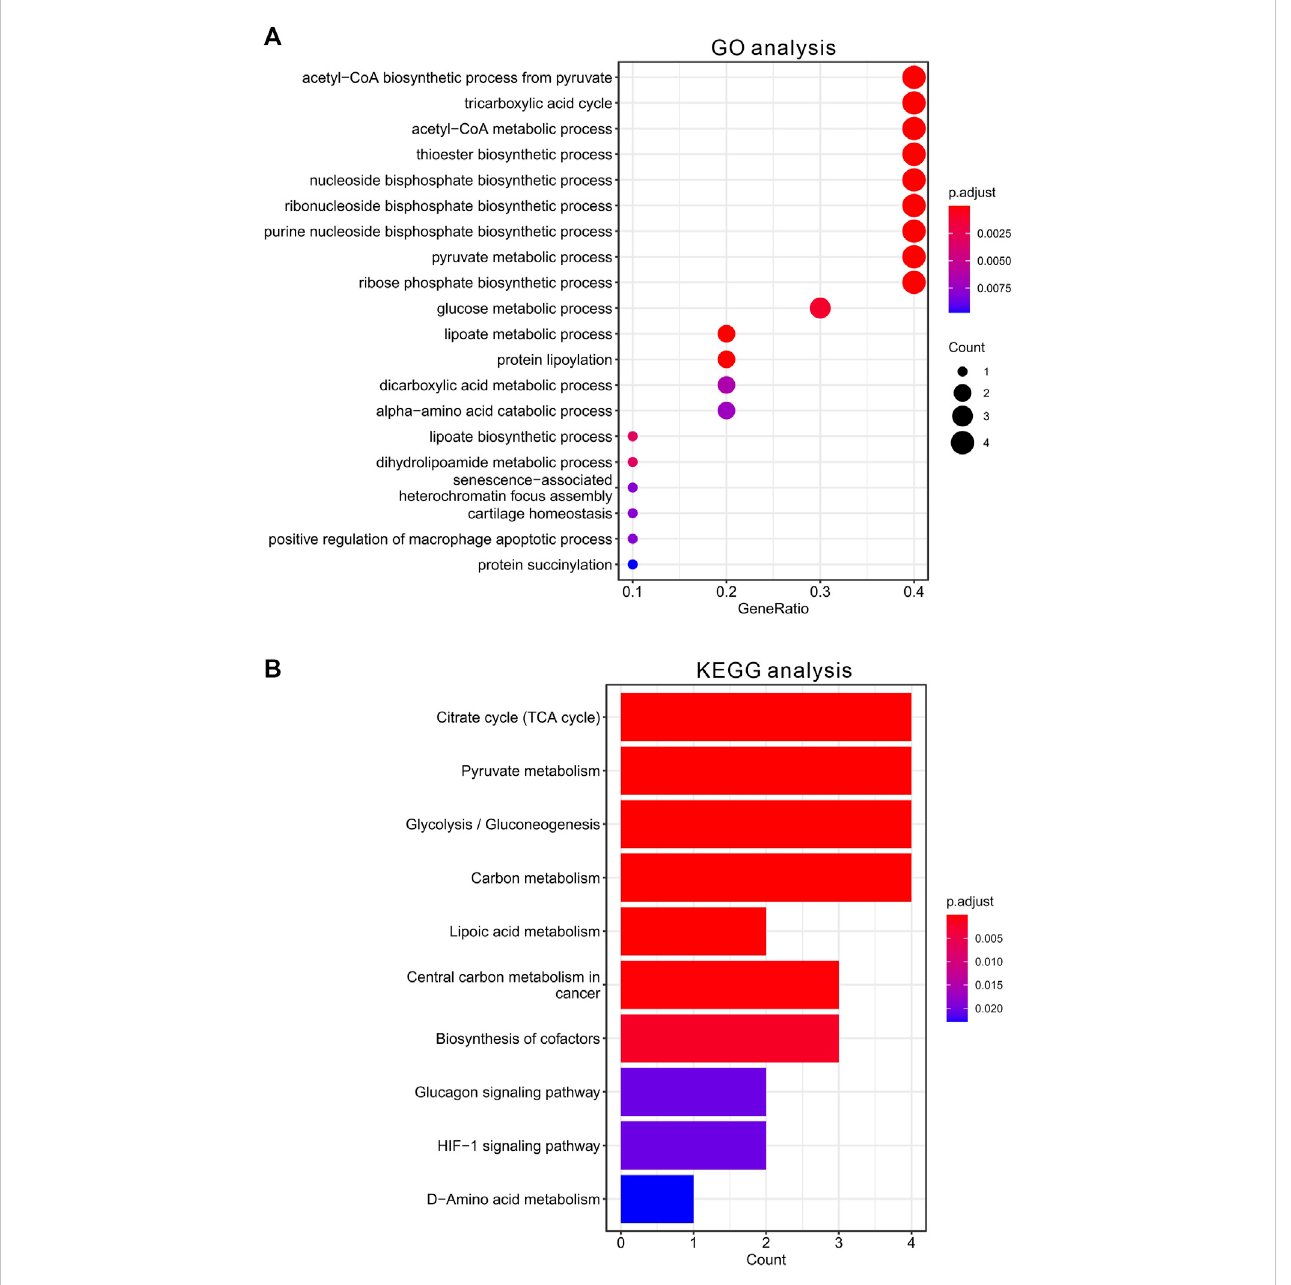
FIGURE 2 FunctionalenrichmentanalysisofCRGsinHCC. (A) Thetop20enricheditemsofCRGsingeneontologyanalysisinbiologicalprocess.Thesizeofcircles represented the number of genes enriched. (B) The top 10 enriched pathways of CRGs in KEGG